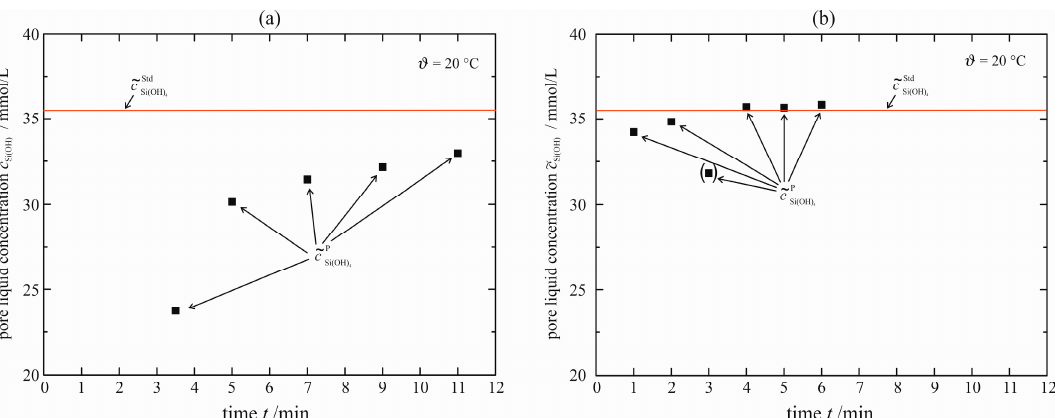
Figure 11. Concentration of monomeric silicic acid in the permeate for membrane Dow Filmtec NF270 ( a ) and Microdyn-Nadir NP010 ( b ) upon filtration of Si standard solution (Certipur ® , Merck Millipore). The courses of enforced syneresis for ϑ = 20 °C with an initial gel sample height s 0 = 16 mm are